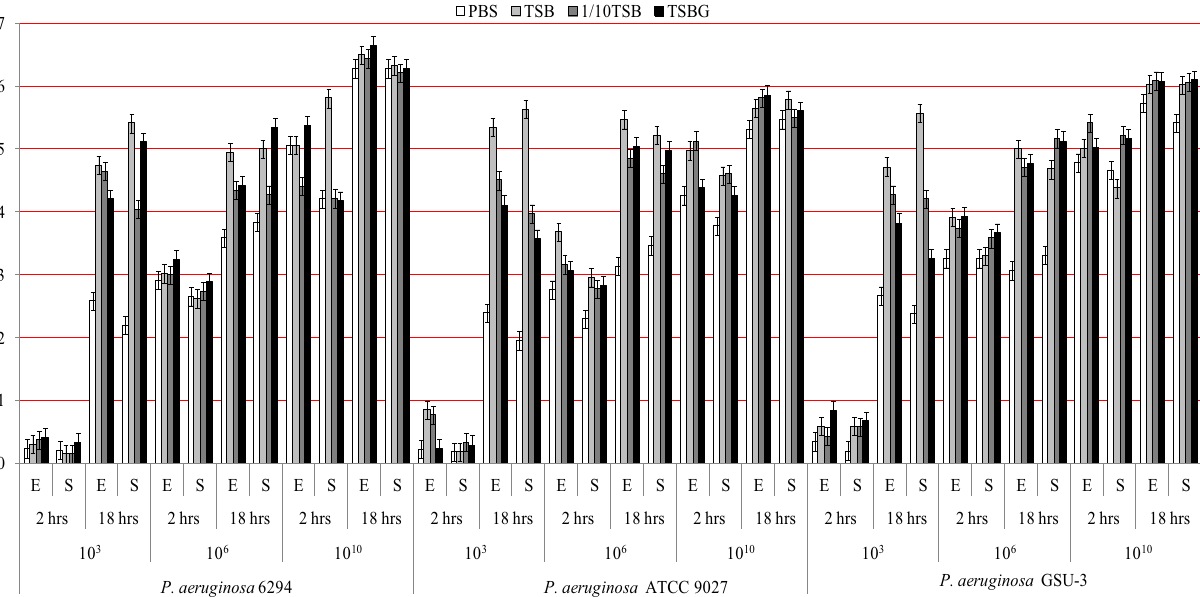
Figure 1. Adhesion of P. aeruginosa to contact lenses under different conditions (E = etafilcon A lenses; S = senofilcon A